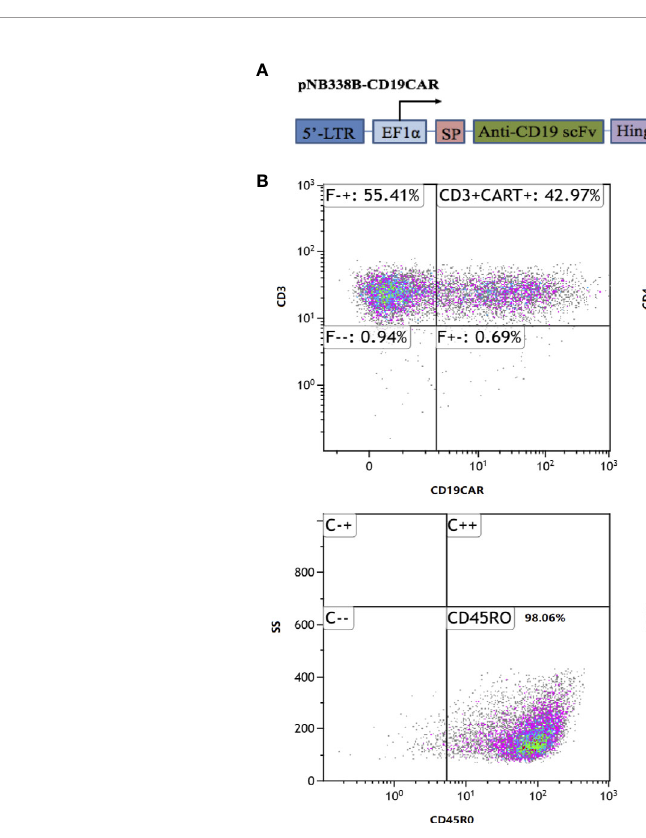
FIGURE 2 | CD19CAR structure and immunophenotype of infused piggyBac -generated CAR19-T cell products. (A) Schematic diagram of CD19CAR. SP, CDS signal peptide; TM, Transmembrane; PA, SV40 Poly A signal. (B) In the fi nal infused products, the CAR transfection ef fi ciency was 42.97%, including 33.28% of CD4 + CAR + cells and 13.54% of stem-cell memory T cells (CD45RO + CCR7 + CD62L +